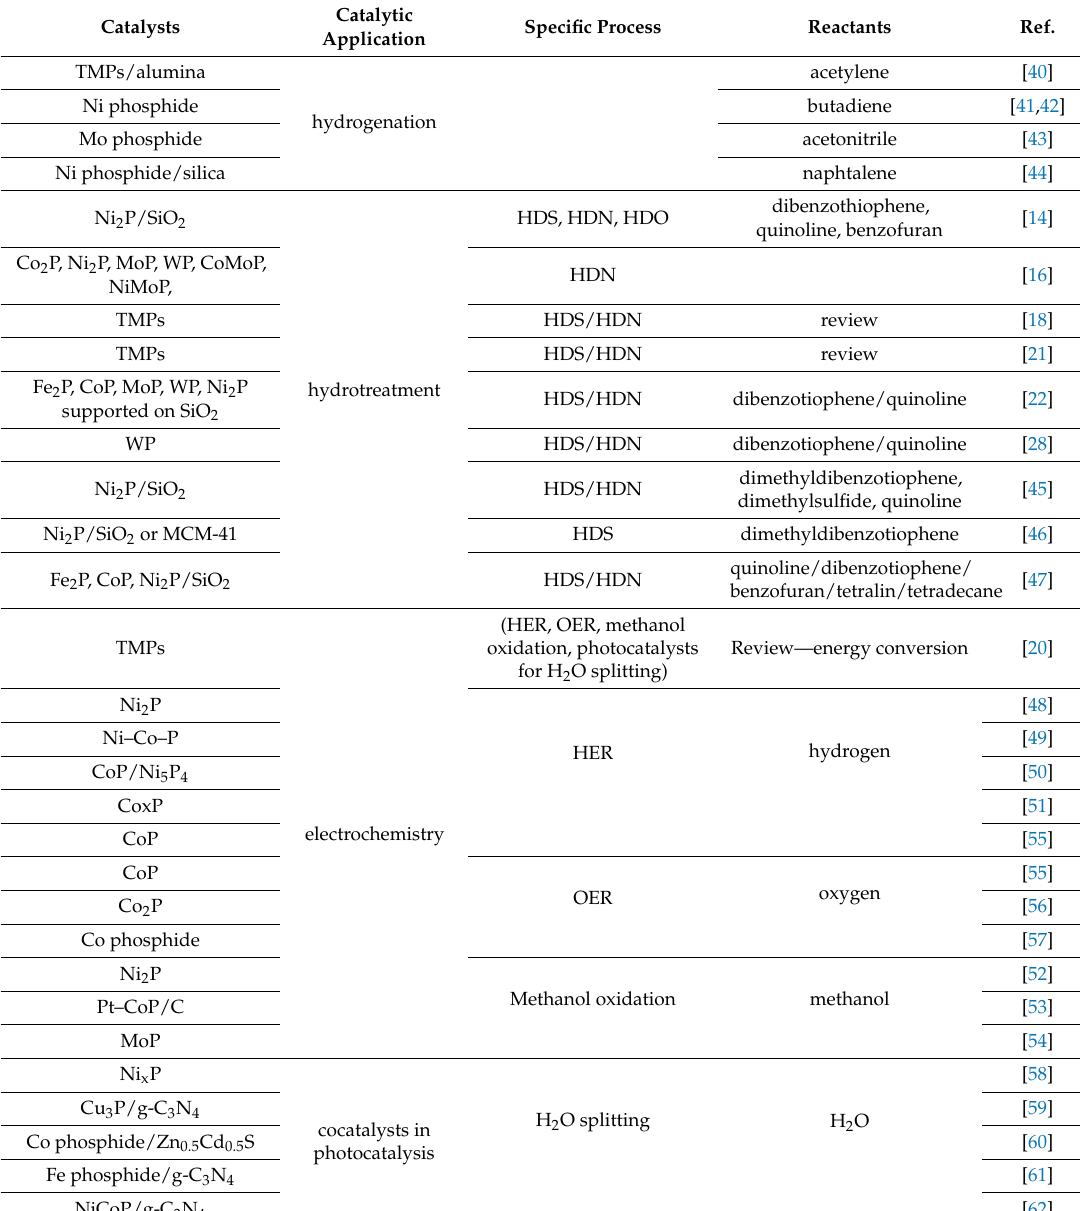
Different catalytic applications of transition metal phosphides